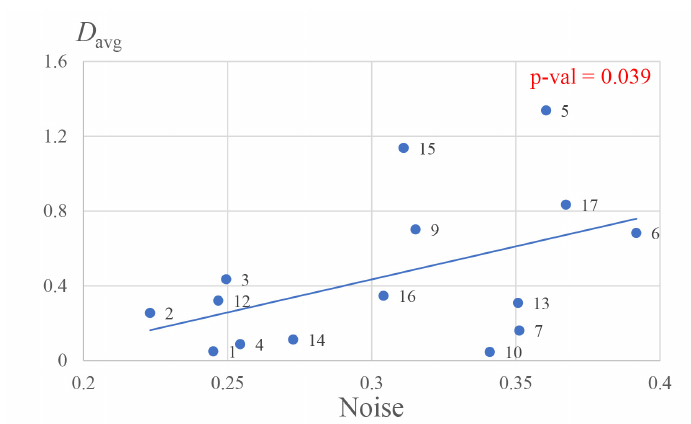
Figure 1. The average power of source activity in the brain volume corresponding to visual cortex versus brain noise for all subjects (numbers denote the subjects). The line is a linear approximation fit ( p = 0.039, R 2 =